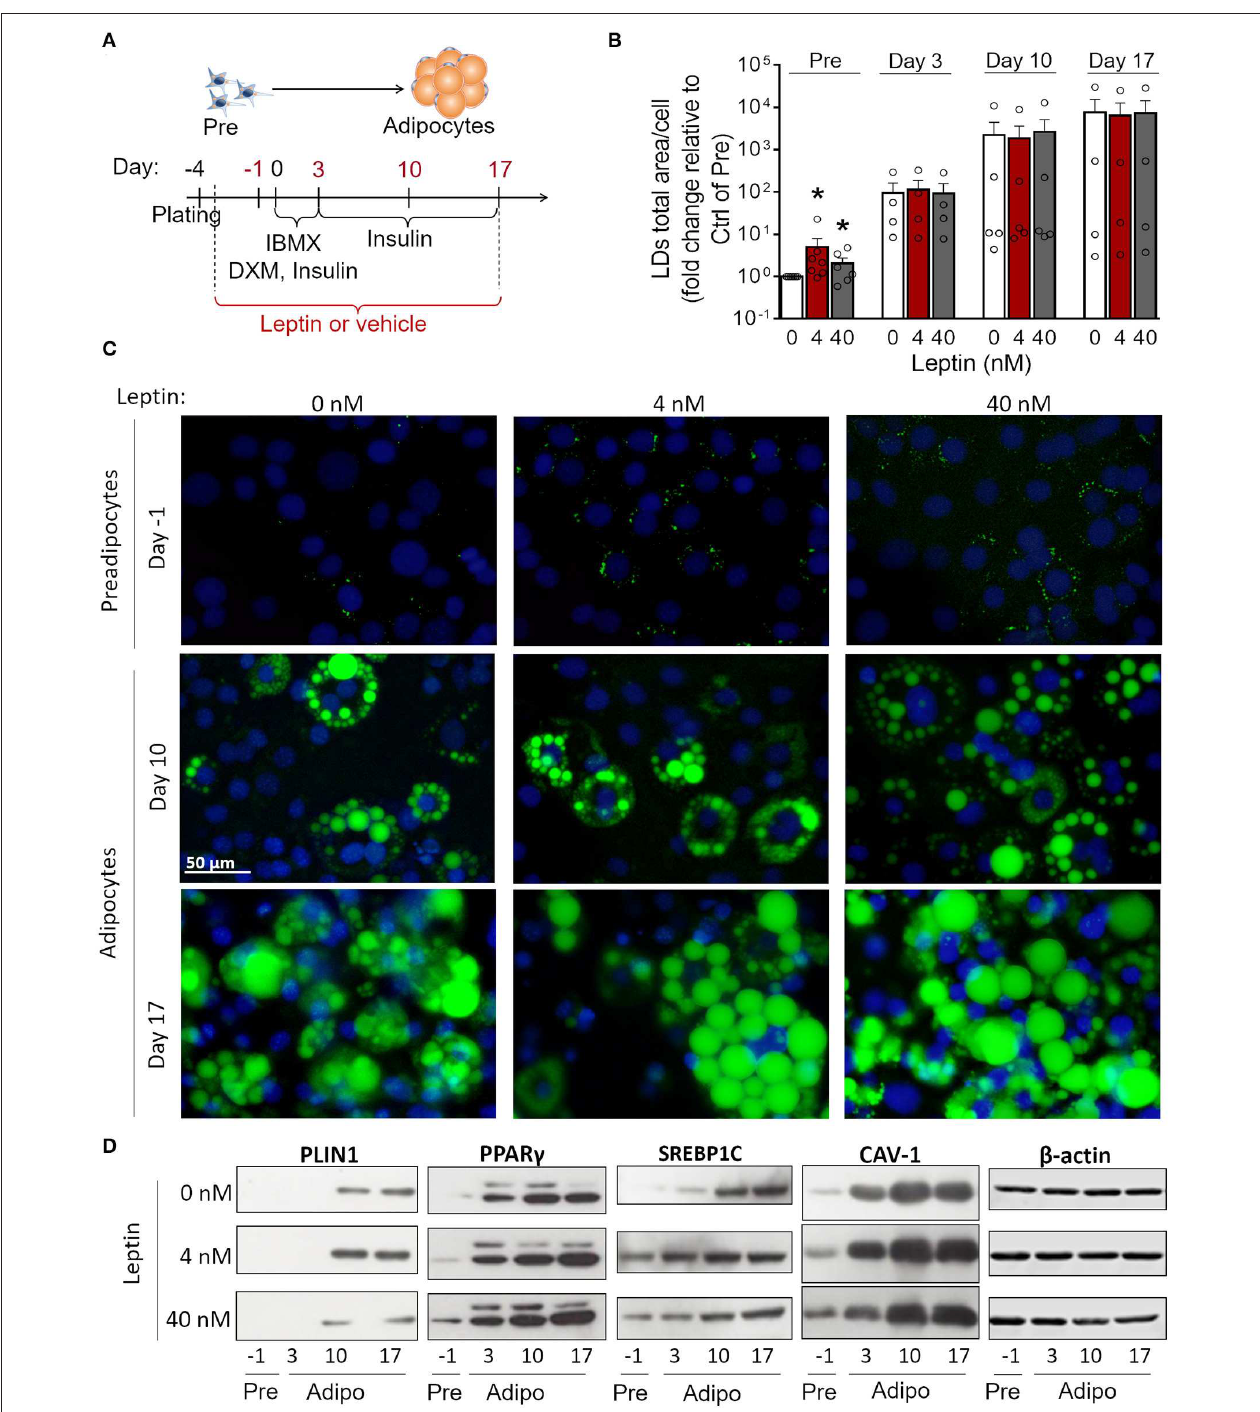
FIGURE 1 | Leptin treatment enhances the expression of adipogenesis- and lipogenesis-related proteins. (A) Schematic representation of experimental design: leptin was administered from day − 3 up to days − 1, 3, 10, or 17 of differentiation. Day 0 represents the day of the induction of differentiation (with IBMX – isobutylmethylxantine, DXM—Dexamethazone and insulin). (B,C) Preadipocytes (day − 1) and adipocytes (days 3–17) were differentiated with leptin (4 or 40nM) and stained with Bodipy (green) for lipid droplets and DAPI (blue) for nuclei. (B) Quantification of the green area per cell in each condition. Bars represent mean ± standard error of the mean of 4–7 independent experiments. *Means p < 0.05 in a Kolmogorov-Smirnov non-parametric test. (C) Representative images of 4–7 independent experiments. Scale bar represents 50 µ m in range. All images have the same dimensions. (D) Western blot analysis of PLIN1, PPAR γ , SREBP1C, caveolin-1 (CAV-1), and β -actin in 3T3-L1 preadipocytes and adipocytes differentiated with or without leptin. Blots are representative of 3–5 independent experiments. Lysates from cells differentiated with 0, 4, or 40nM were analyzed in the same gel and cropped for clearer comparison among groups.